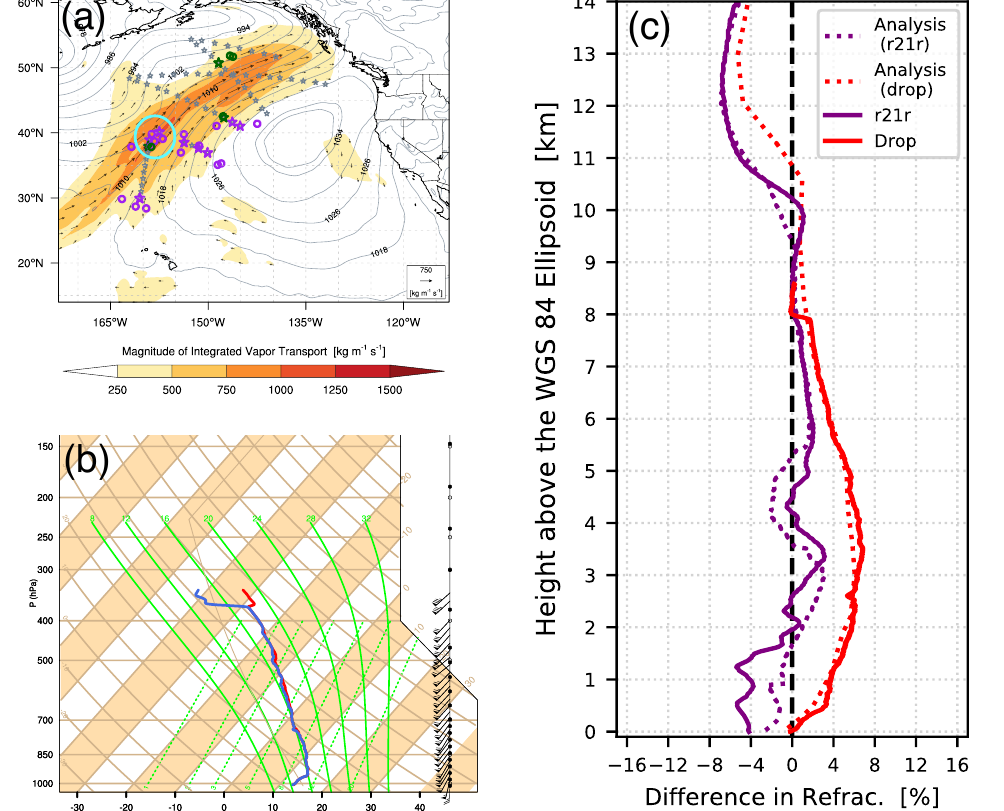
Figure 2. Same as Figure 1 but for an example occultation from the COSMIC-2 dataset (purple) that was approximately 110 km apart in space and nearly simultaneous in time during the fourth intensive observing period (IOP04) of AR Recon